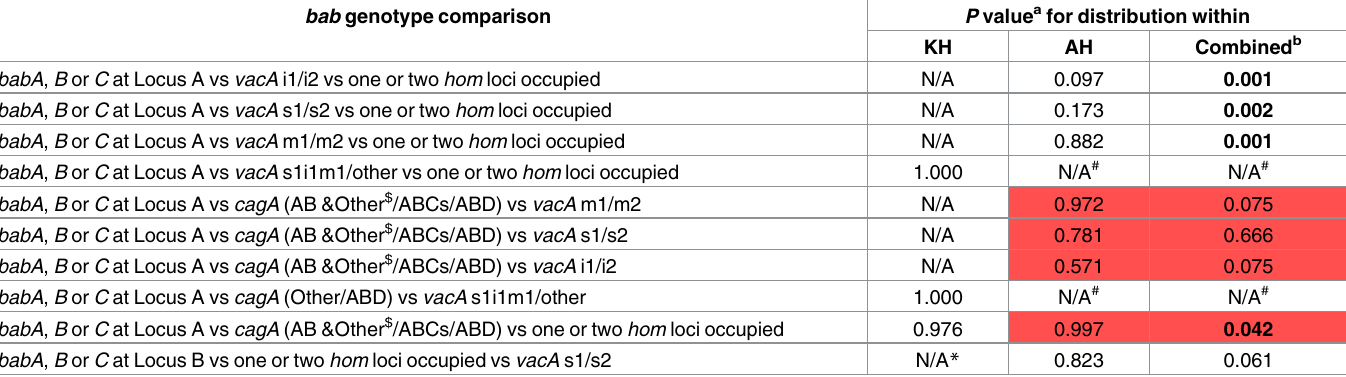
Table 4. Three-way comparisons of bab genotype and other factors in both